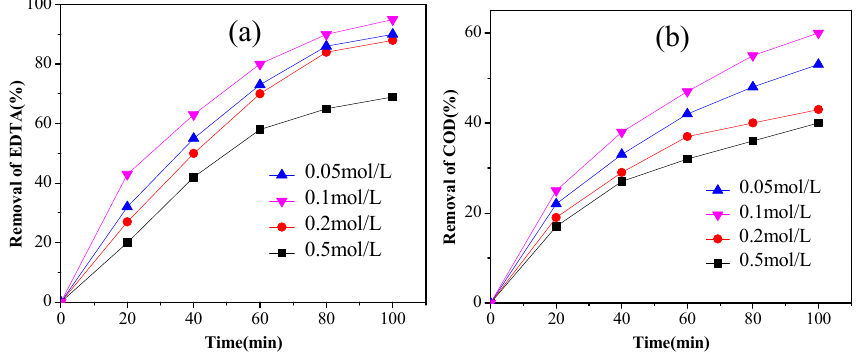
Figure 3. The effect of supporting electrolyte (Na 2 SO 4 ) concentration on the EDTA removal of ( a ) concentration, ( b ) COD (3% Pt/ACF electrode; initial pH 5.0; initial EDTA concentration 300 mg/L; current density 40 mA/cm 2 ). COD: chemical oxygen demand.